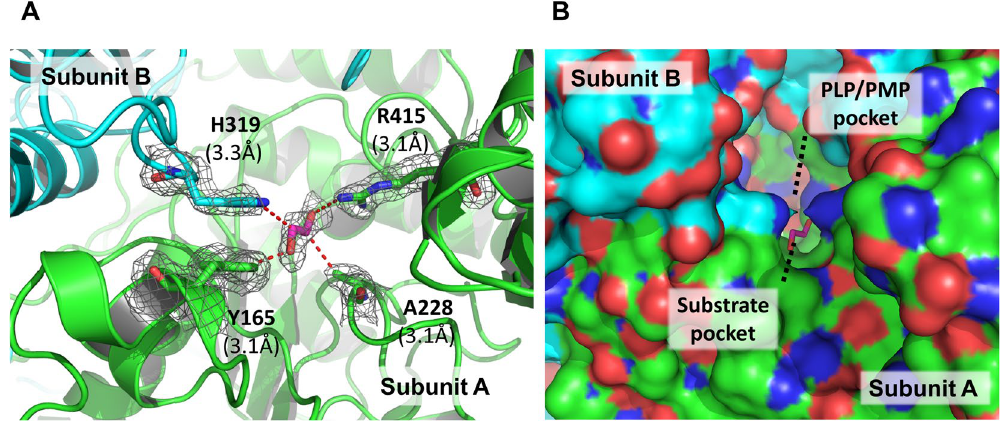
Figure 4. Substrate pocket in the A subunit of apo Vfat. ( A ) The substrate pocket in apo Vfat. The stick representation shows that four residues that are in close proximity (within 3.5 Å) from an unidentified, substrate-like, molecule. ( B ) Close-up surface representation of the cofactor- and ligand-binding site entrances in subunit A of apo Vfat. The unidentified, substrate-like, molecule is shown as a